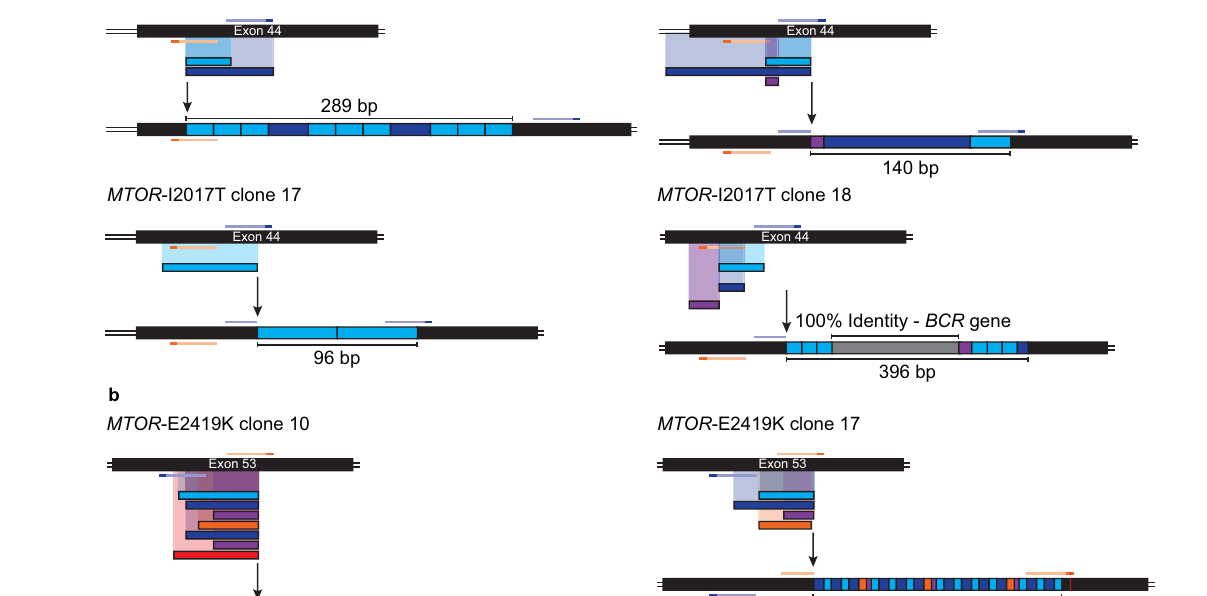
(Supplementary Fig. 21). The same was true when overexpressing a dominant negative MLH1 to inhibit MMR as described in the PE5 strategy 7 (Supplementary Fig. 21). Overall, our observations sug- gest that large PE3-mediated insertions are frequent and under- estimated when using standard genotyping methods.